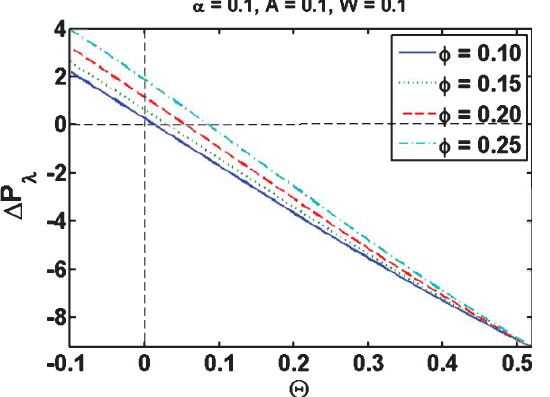
Fig.17. Variationin (cid:12)P λ against (cid:10) fordifferentvaluesofamplitude ratio ( φ